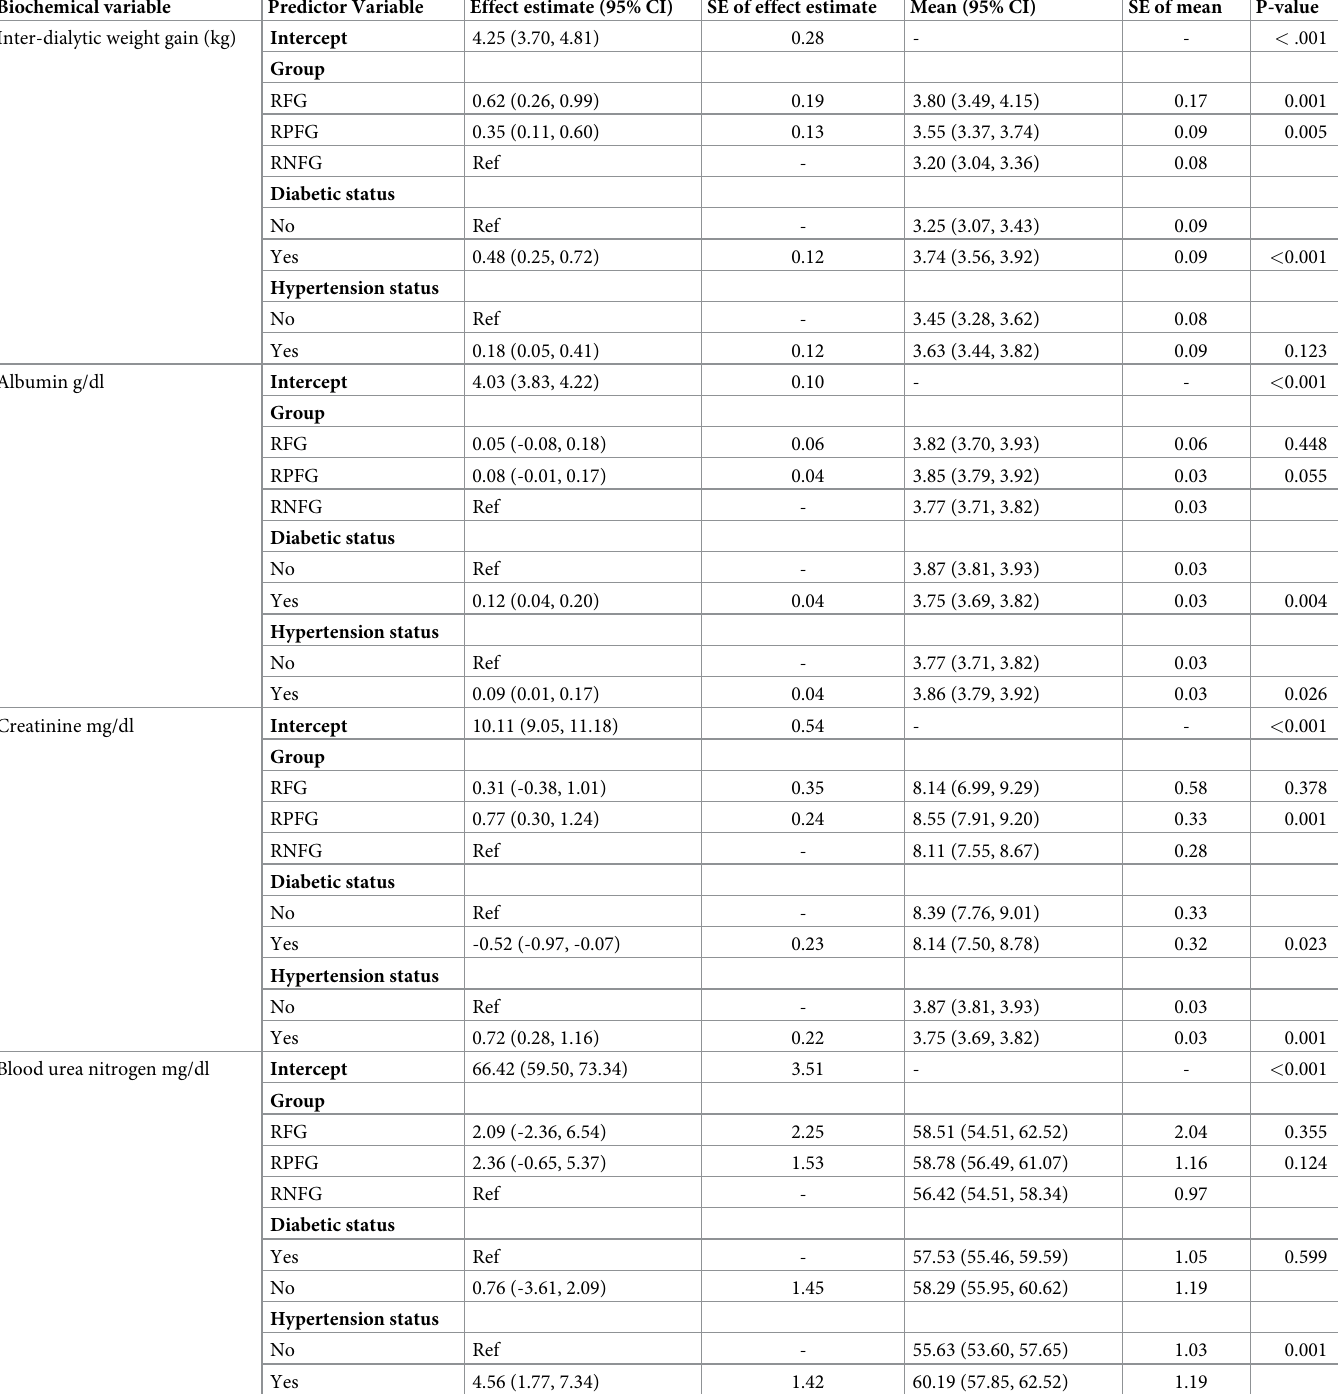
Table 2. Adjusted � effects of Ramadan fasting on clinical and biochemical